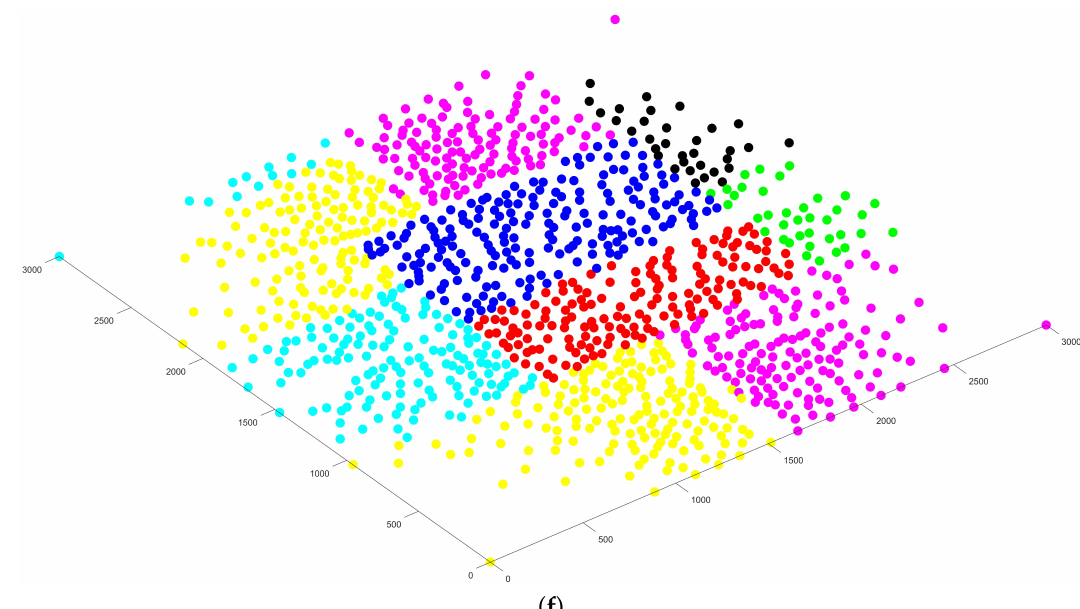
Figure 6. The area division results of: ( a ) mountain topography in aerial view; ( b ) mountain topography in top-down view; ( c ) valley topography in aerial view; ( d ) valley topography in top-down view; ( e ) complex topography in aerial view; and ( f ) complex topography in top-down